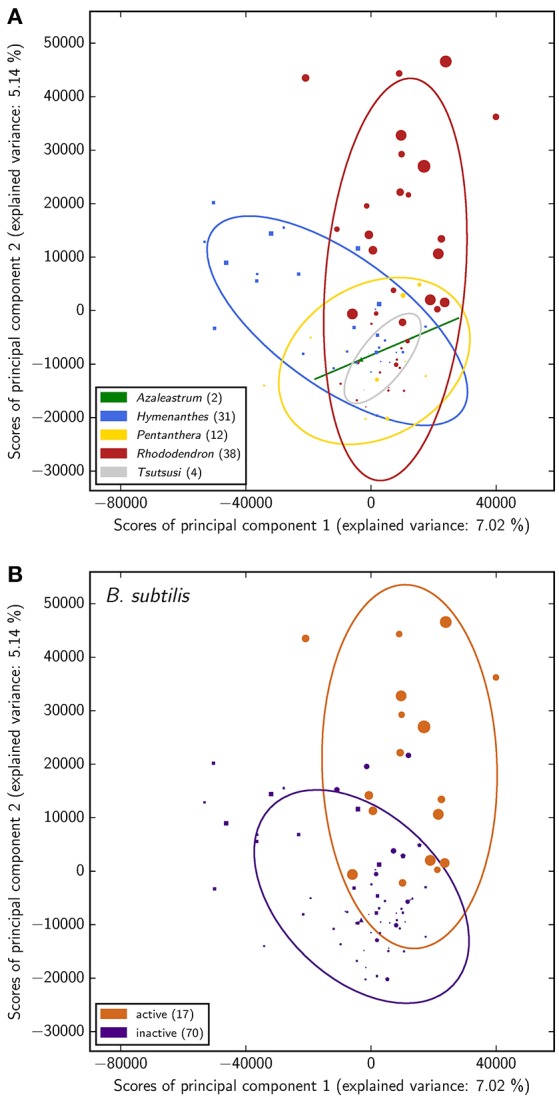
Principal component analysis of the phytochemical data for all 87 Rhododendron species. The scores of the principal components corresponding to the species are colored with respect to the corresponding subgenera (A) and antimicrobial activity classification (B), respectively. In addition, the item shape highlights the subgenus of each species (△:Azaleastrum, ◻:Hymenanthes, :Pentanthera, ◯:Rhododendron, ▽:Tsutsusi) and the item size illustrates the antimicrobial activity of the respective species (the larger the more active).